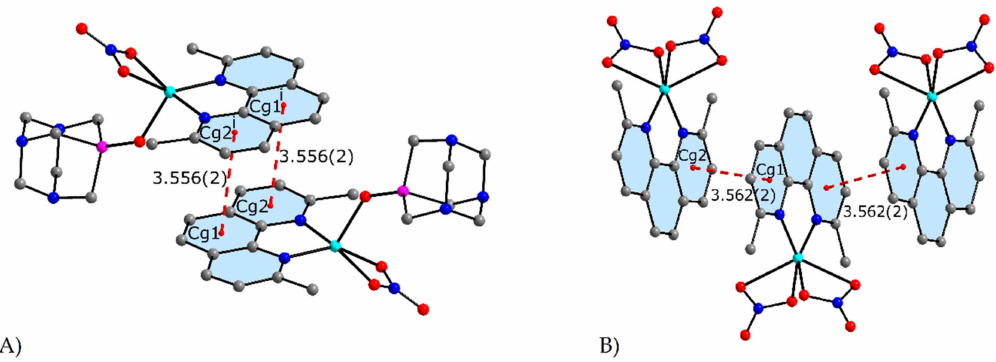
Figure 2. Molecular structure of compound 3 with atom labelling scheme. Ellipsoids shown at the 50% probability. Color code: Grey, carbon; blue, nitrogen; red, oxygen; cyan, copper; light grey, hydrogen. Selected bond lengths (Å) and angles ( ◦ ): Cu-O12, 2.42; Cu-O22, 2.006; Cu-N11, 1.989; O12-Cu-O22, 57.62; O12-Cu-N11, 96.32; O12-Cu-N11, 119.68; O12-Cu-O12, 131.58; O12-Cu-O22, 87.13; O22-Cu-N11, 152.35; O22-Cu-N11, 99.67; O22-Cu-O22, 88.88; N11-Cu-N11, 84.89; N11-Cu-O22, 99.67.